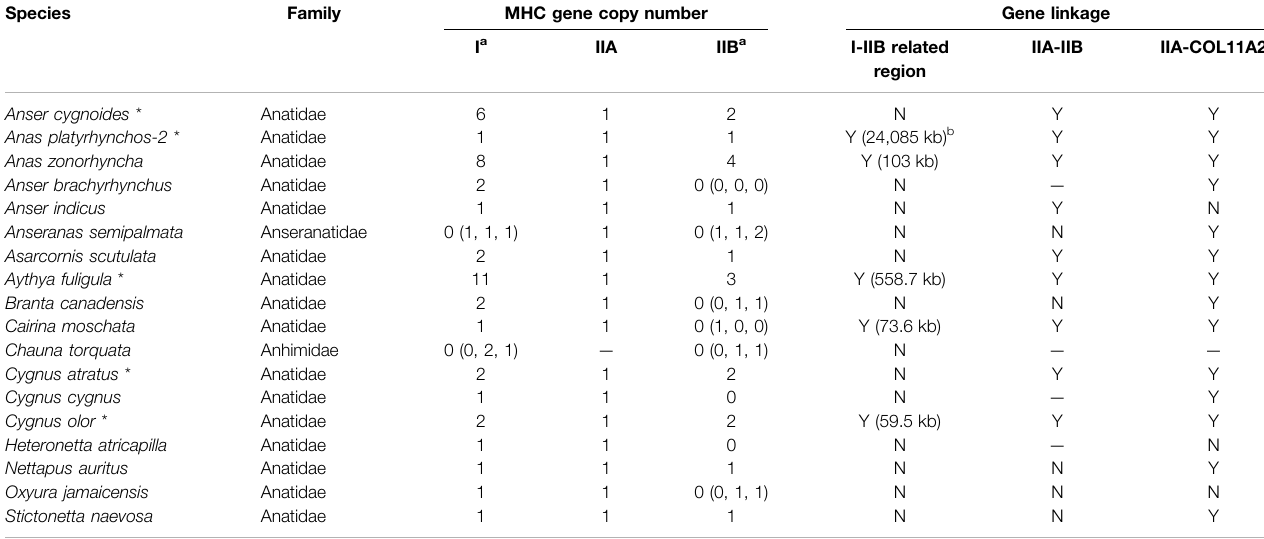
TABLE 3 | Gene numbers, linkage, and gene arrangement of MHC-I and MHC-II genes in waterfowl Anseriformes (SGS- and TGS-based genomes) TGS-based data were marked with asterisks (*). Species Family